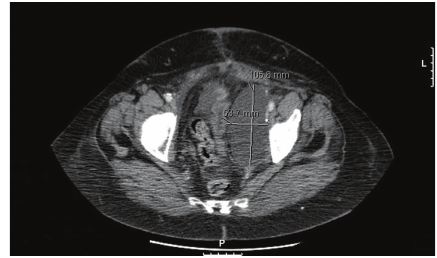
Figure 1: Pelvic lymphocele